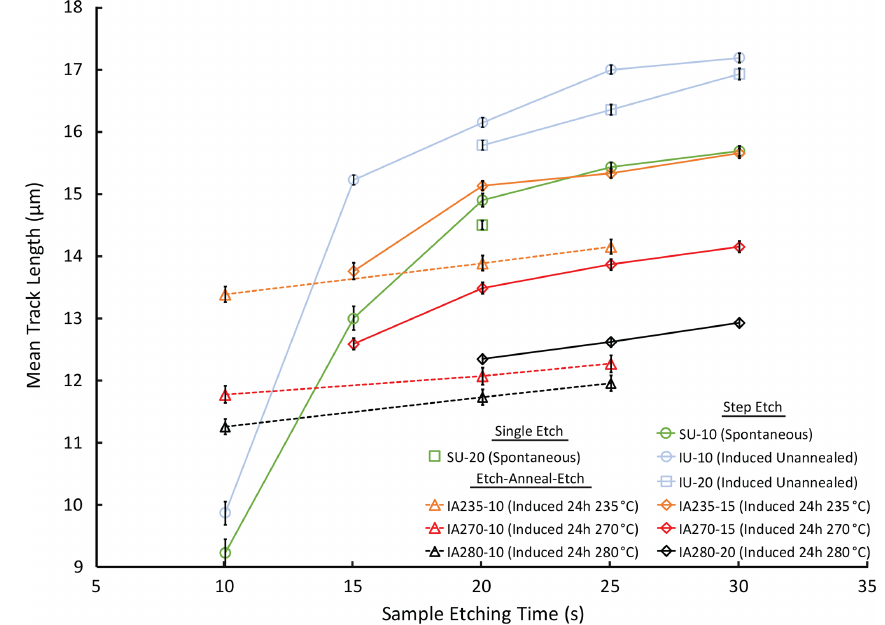
Figure 2. Mean track length data used in this study, from Tamer and Ketcham (2020a, b); see Table 1. Error bars show 1SE. Only the first step of etch–anneal–etch experiments are used here, but post-complete-annealing etching steps at 20 and 25s, connected by dashed lines, indicate bulk etching rate, v B